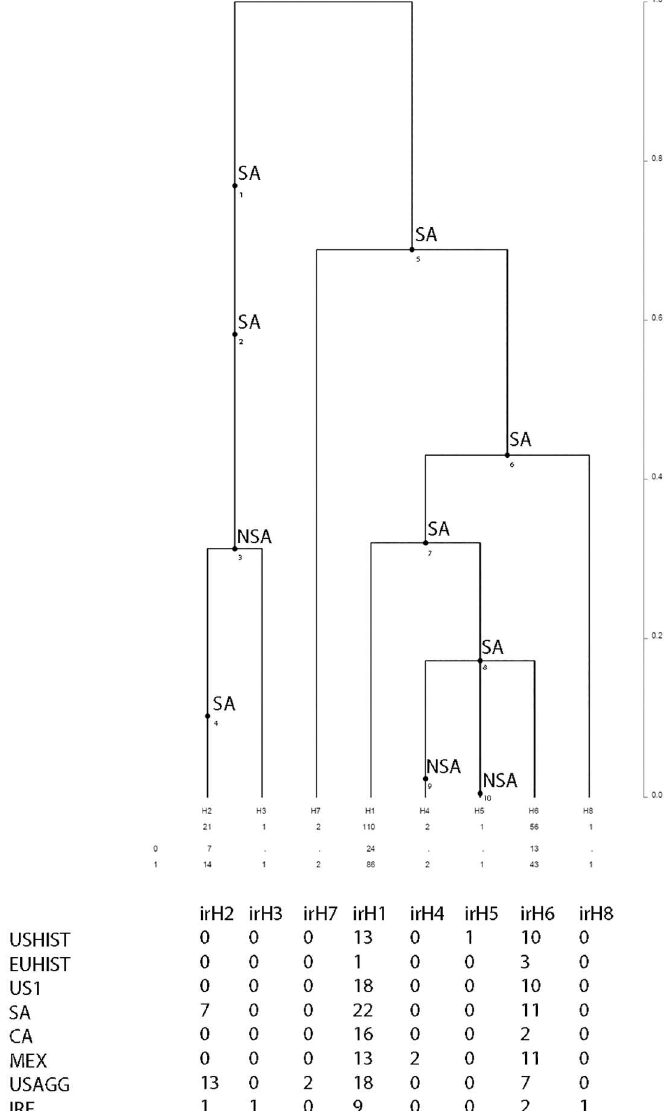
Fig 5. Coalescent analysis using the ras gene from modern and historic samples of Phytophthora infestans . The distribution of mutations for South American(SA) and non-SouthAmerican(NSA) populations are shown. The frequency of occurrence of haplotypesand the times to the most recent common ancestor are shown in coalescentunits for each populationexaminedincludingUS Historic (USHist), EuropeanHistoric (EUHist), US-1, South American(SA), CentralAmerican(CA), Mexican (MEX), US Aggressive (USAGG) and Ireland (IRE). Times are not to scale. Estimates were based on 10 millioncoalescentsimulations and fifteen independent runs to ensure convergence. Simulationswere performedassumingconstant populationsize and utilizedthe largest nonrecombiningblock of